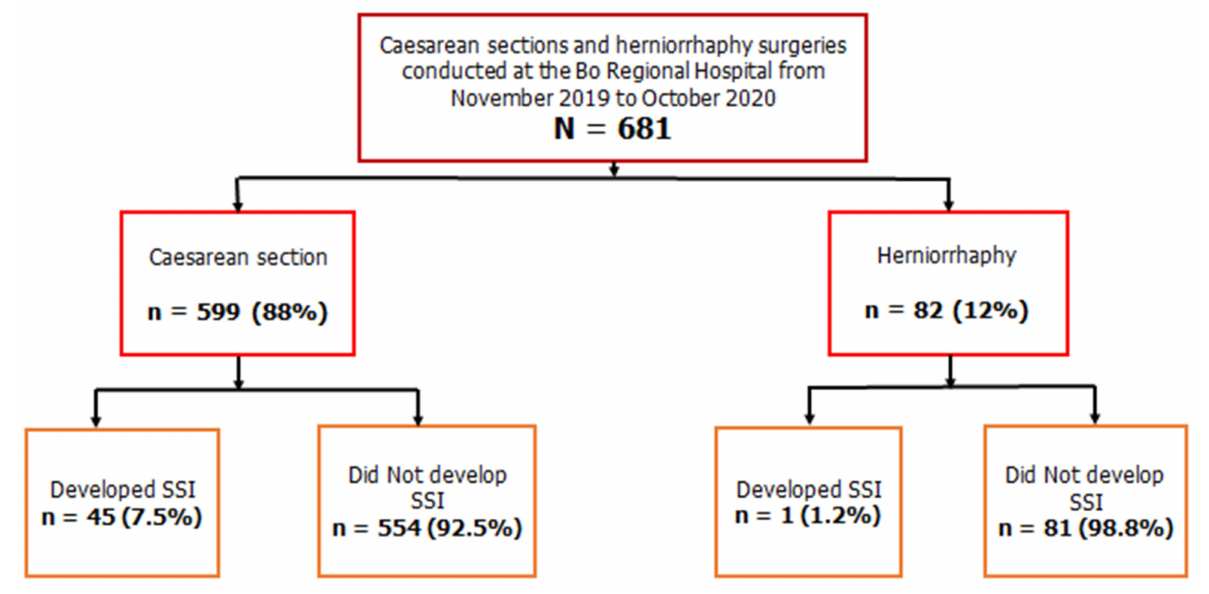
Figure 1. Flowchart showing the number and proportion of surgical site infections (SSI) among surgeries performed by type in the maternity and surgical units, Bo regional hospital, November